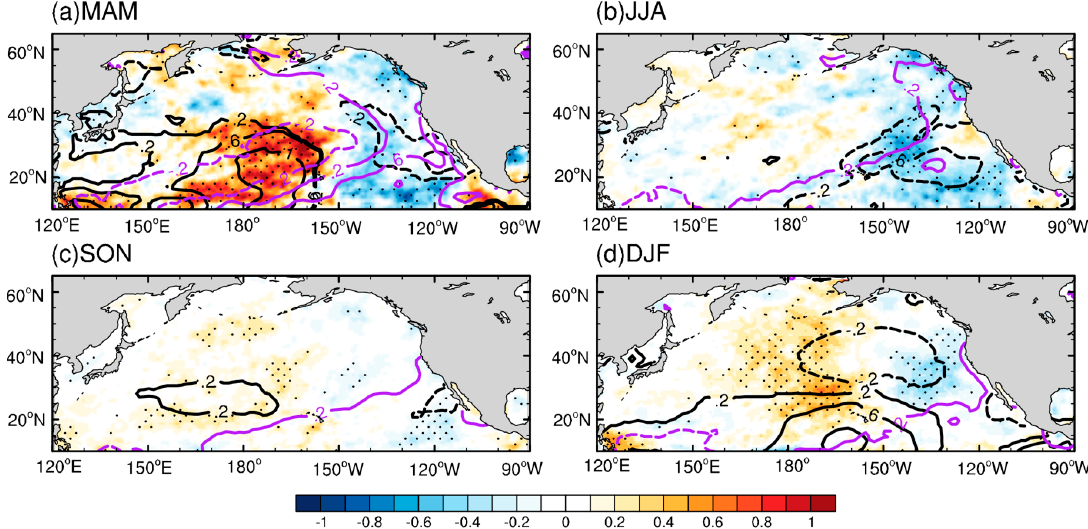
Figure 7. Coefficients of interannual LCF (shading; units: %), SST (purple contour; units: K), and EIS (black contour; units: K) onto the synchronization Niño-3.4 index for ( a ) spring, ( b ) summer, ( c ) autumn, and ( d ) winter. Stippling indicates the 90% confidence level using the t test. Contours indicate statistically significant positive (solid) and negative (dashed) differences.